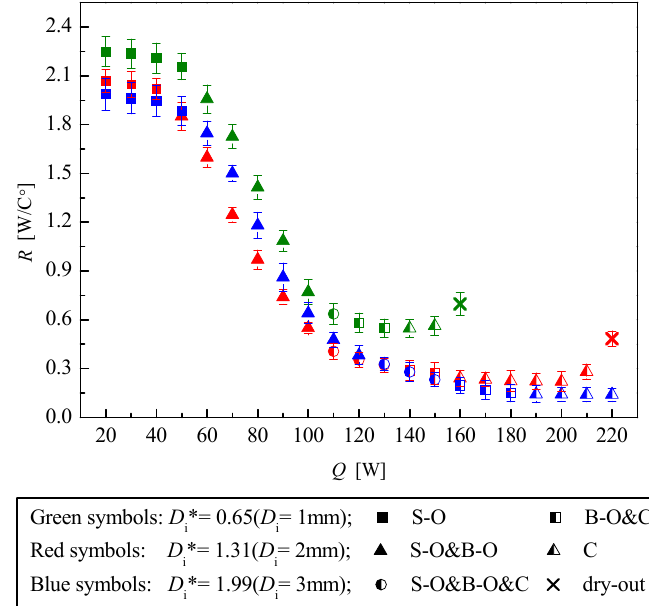
Figure 9. Variation of thermal resistance and fluid flow motions versus increasing heating load under different inner diameters of the OHPs.